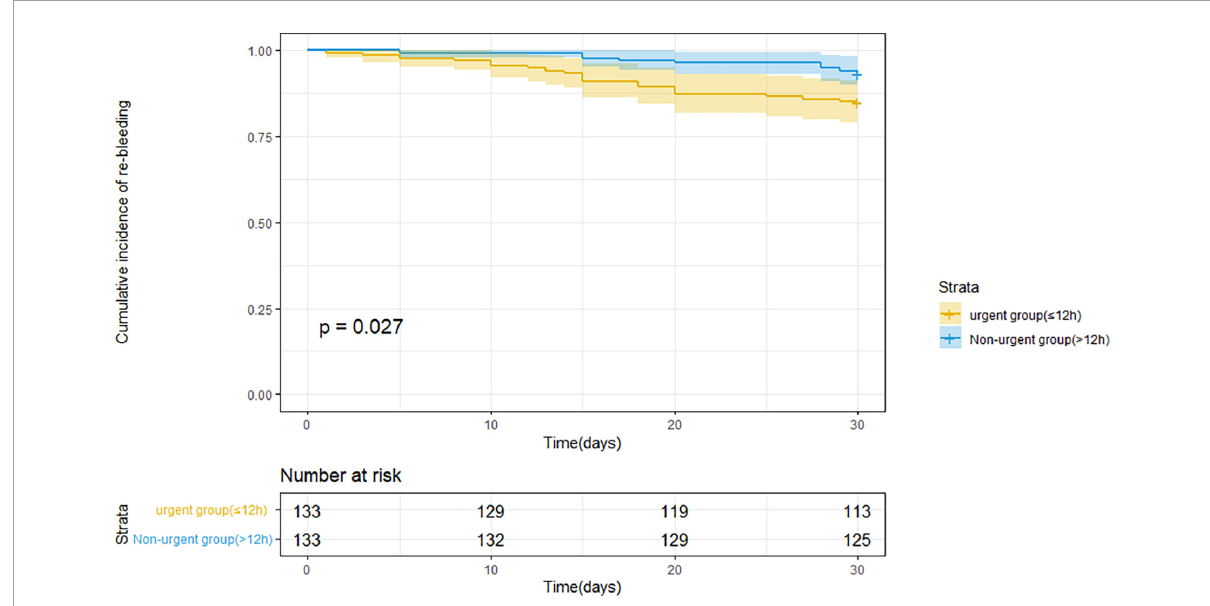
FIGURE2 Kaplan–Meier estimates of 30 days rebleeding in patients with acute variceal bleeding after propensity score